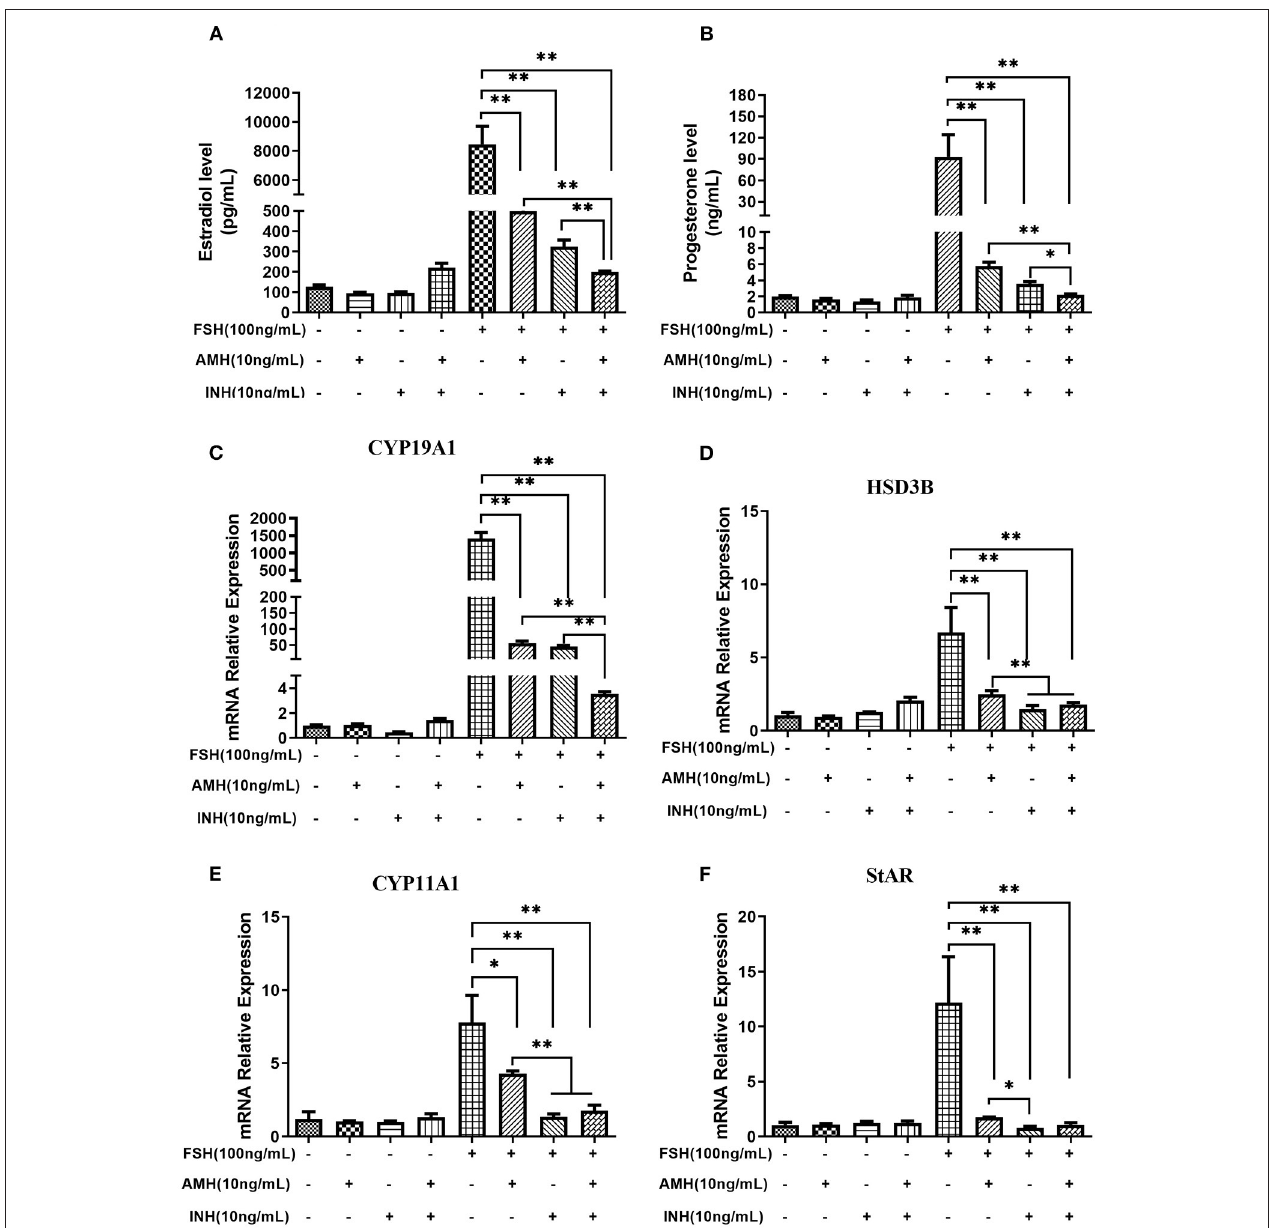
FIGURE 3 | Synergistic effects of INHA and AMH on steroidogenesis by primary granulosa cells. (A,B) Estradiol and progesterone production in cells treated with INHA, AMH, or FSH alone or their combinations. (C–F) Relative expression of transcripts for CYP19A1 , HSD3B , CYP11A1 , and StAR in cells treated with INH, AMH, or FSH alone or their combinations. Data are presented in mean ± SEM. * p < 0.05 and ** p < 0.01 between the indicated groups.